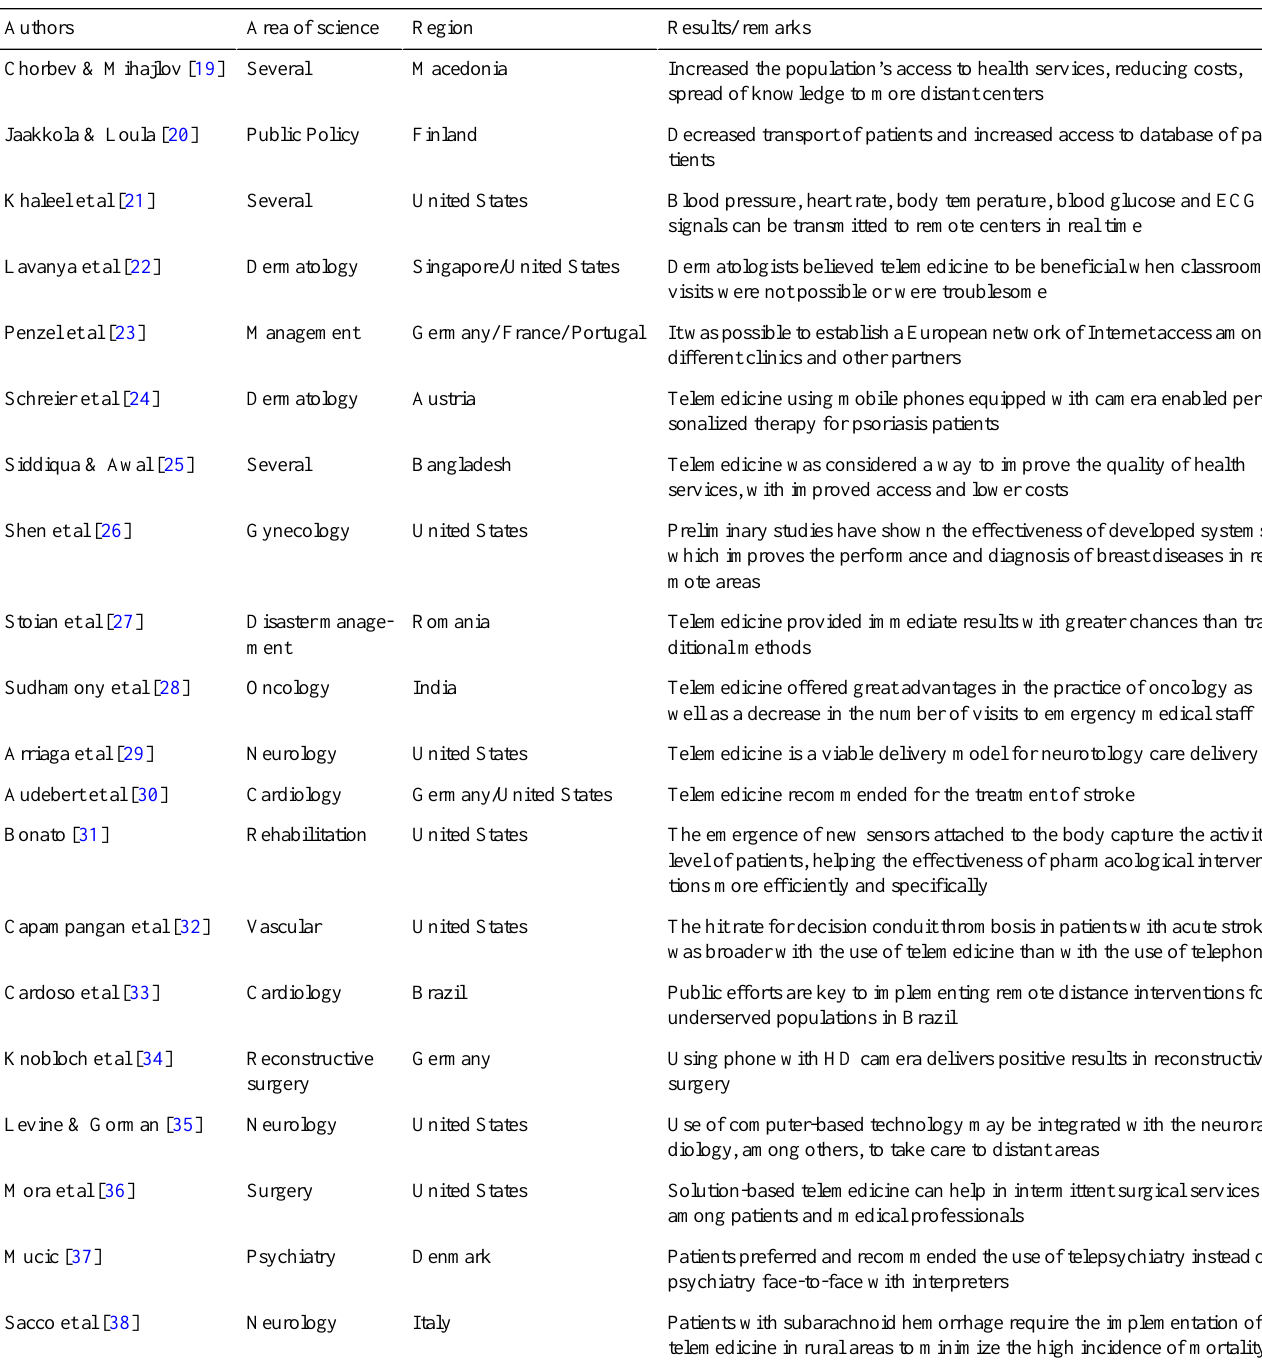
Table 1. Some publications in diverse areas of telemedicine.